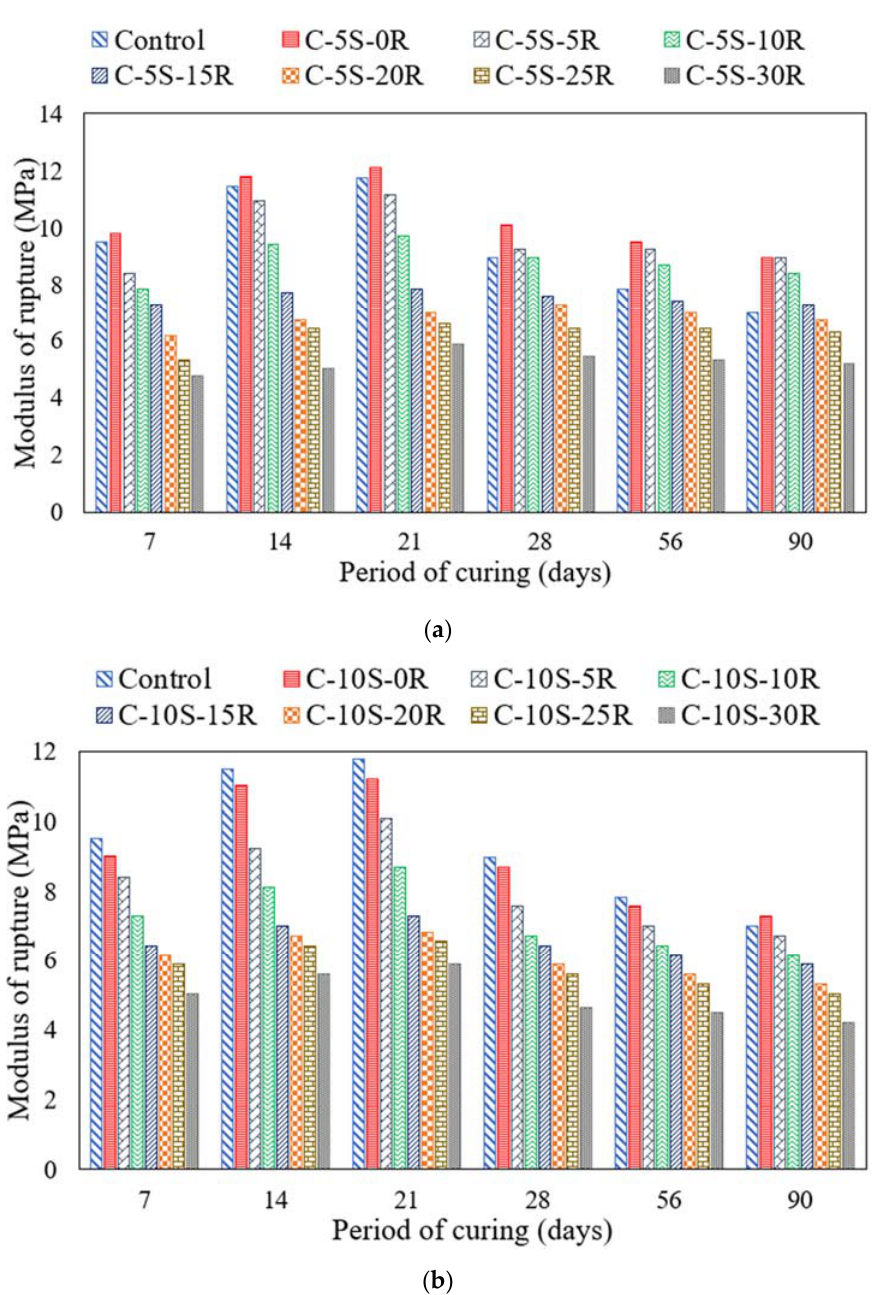
Figure 9. ASR effects on Flexural Strength incorporating various proportions of SF and RHA. ( a ) C ‐ 5S ‐ (0 to 30)R, ( b ) C ‐ 10S ‐ (0 to 30)R.